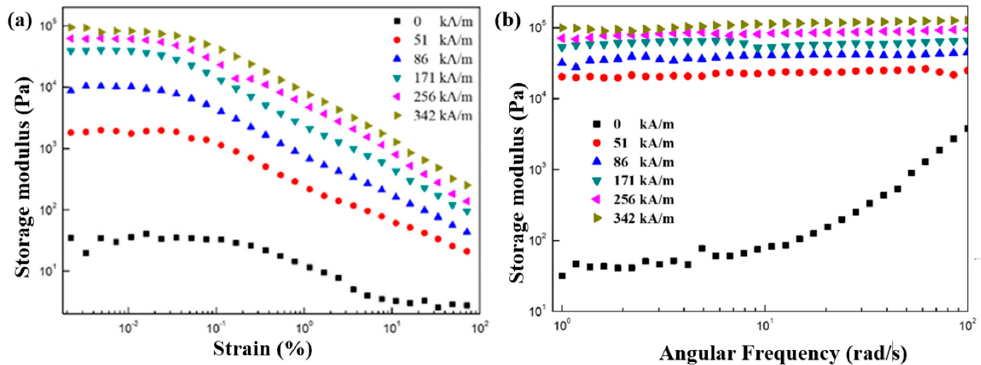
Figure 17. Dynamic oscillation tests of Fe 3 O 4 / POA based MR fluid (10 vol %): ( a ) storage modulus as a function of strain with fixed angular frequency of 6.28 rad / s; ( b ) storage modulus as a function of angular frequency with constant strain of 0.005% (Lee et al. [81], © by authors, 2019).